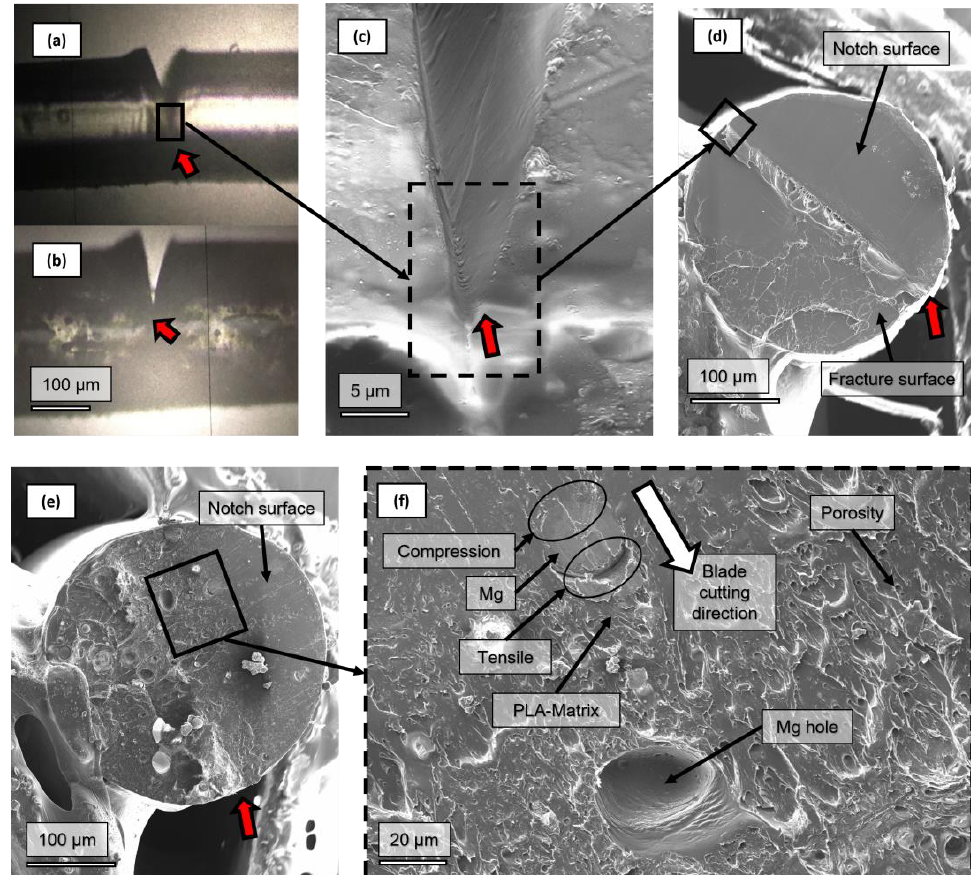
Figure 13. Detail of the notch made on the PLA and PLA-Mg samples and the fracture surface: ( a ) PLA filament with notch; ( b ) PLA-Mg filament with notch; ( c ) detail of the notch from a lateral view and a notch tip radius of 1 μm ; ( d , e ) notch and crack surface after tensile tests of PLA and PLA-5Mg, respectively; ( f ) detail of the PLA-5Mg notch surface. Small arrows indicate the edge of the notch.